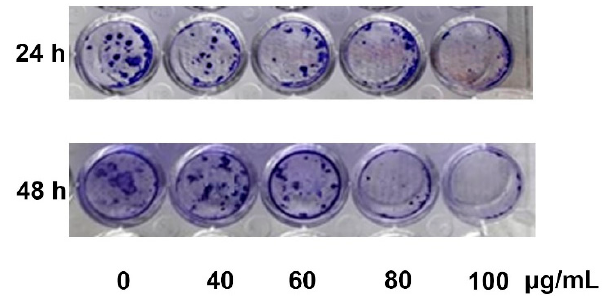
Figure 2. HepG2 cells after 24 h and 48 h treatment with YLE were allowed to grow into visible colonies for an additional 2 weeks. The figure presents one of three independent experiments.